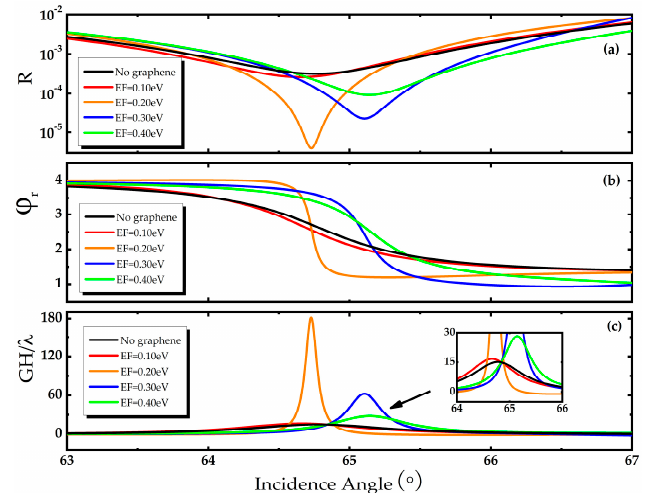
Figure 2. ( a ) Reflectance R as a function of incident angle at different Fermi energy, ( b ) Reflected phase ϕ r as a function of incident angle at different Fermi energy, ( c ) Goos–Hänchen (GH) shift as a function of incident angle at different Fermi energy, the inset is an enlarged view of the GH shift in the range of 64~66 ◦ , in which Ag thickness d 2 = 15 nm, Au thickness d 3 = 20 nm, hBN thickness 131 nm , graphene layer N = 1.